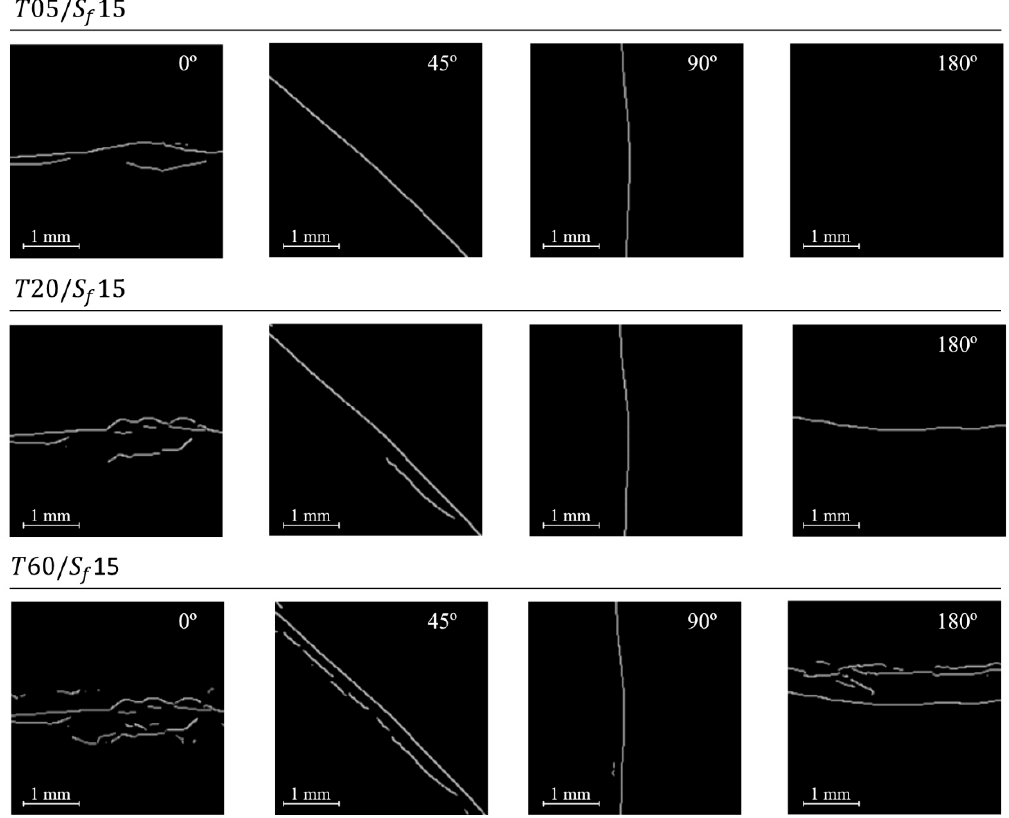
Figure 15. Samples of S 03 contour points obtained with Canny for different angular positions and test configurations: T 05/ S f 15 ( upper row ), T 20/ S f 15 and T 60/ S f 15 ( lower row ).